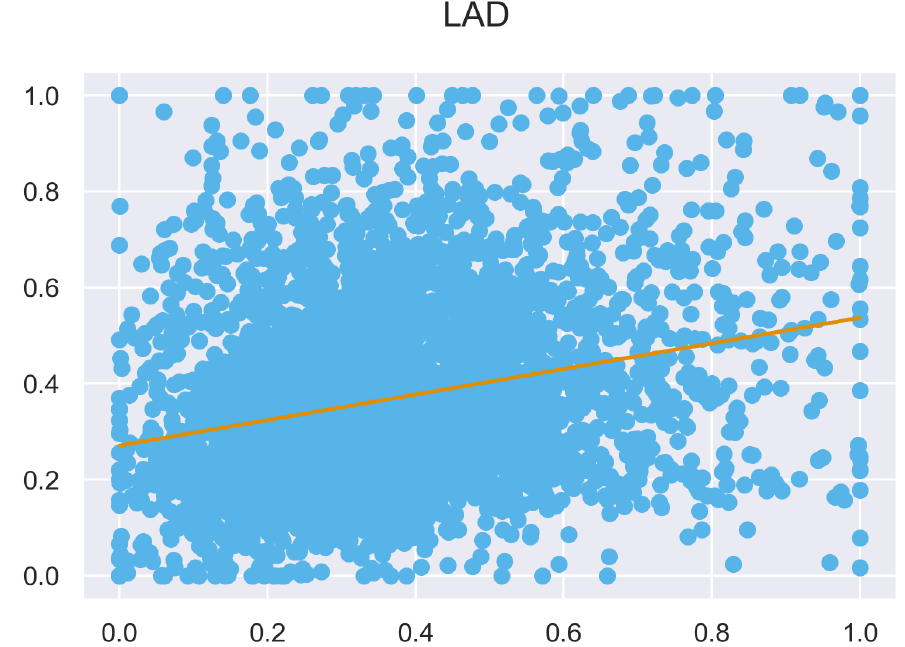
Figure A30. ULS and TLS LAD regression at 1m grid size.